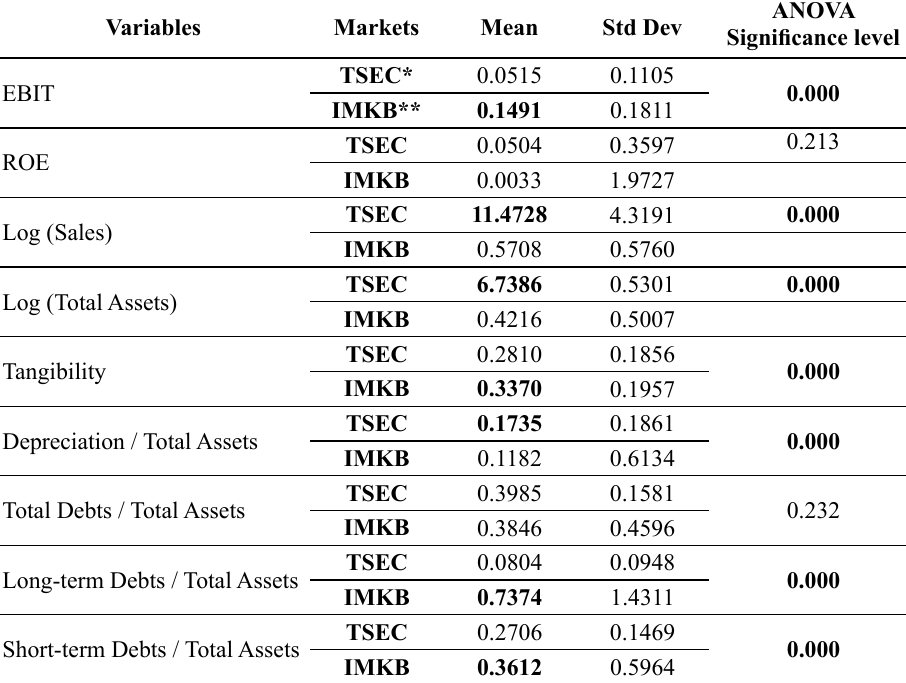
Table 2. Descriptive statistics and ANOVA